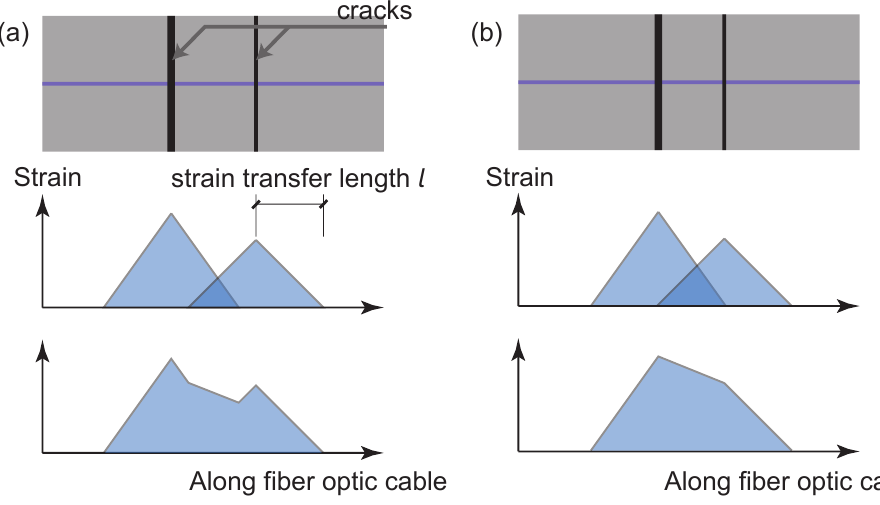
Figure 21. Illustration of the strain superposition in the fiber optic cable: ( a ) enough spacing to distinguish different cracks; ( b ) insufficient spacing between